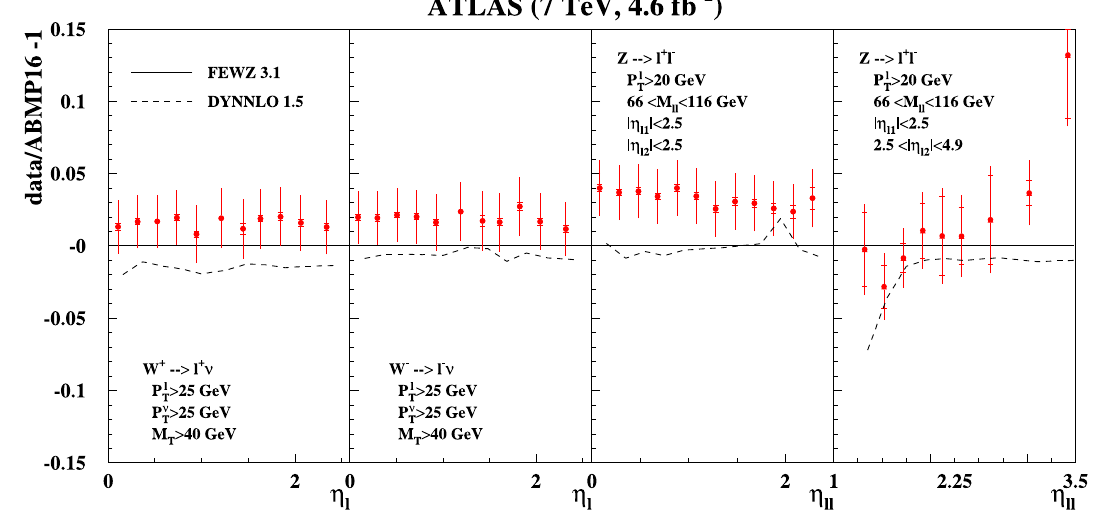
Fig. 5 The pulls for the ATLAS data measured in inclusive pp → W ± + X → l ± ν + X and pp → Z /γ ∗ + X → l + l − + X production √ s = 7 TeV [6] with the statistical (inner bar) and the total uncer- at tainties, including the systematic ones. The fiducial cuts on the decay